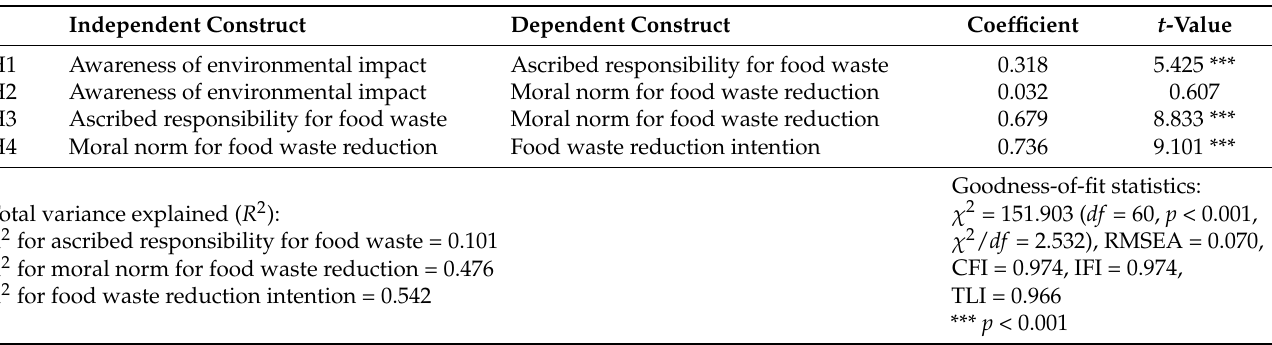
Table 3. Results of the structural equation modeling ( n =